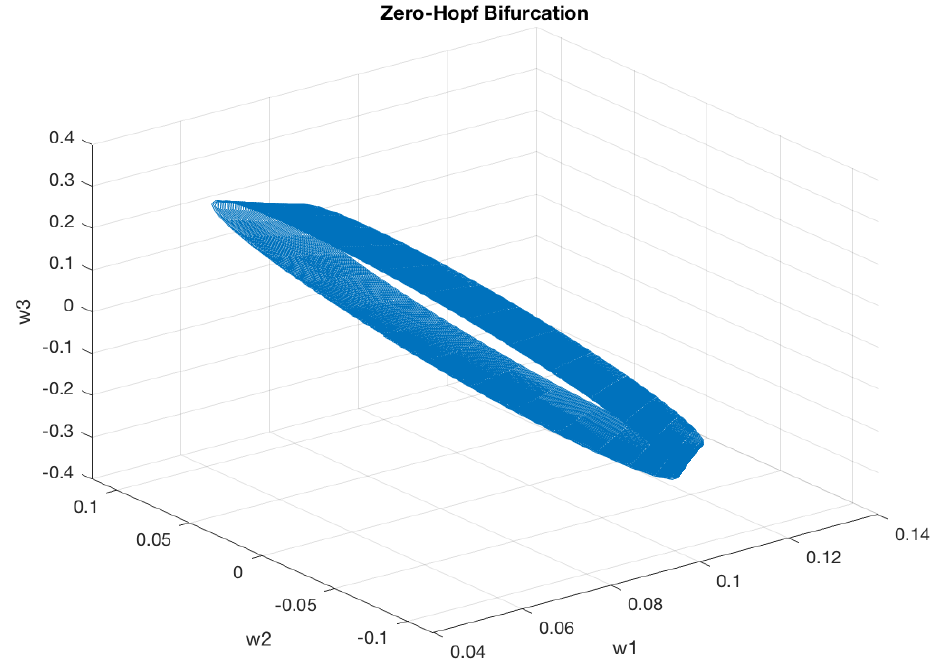
Figure 4. The zero-Hopf cycle.